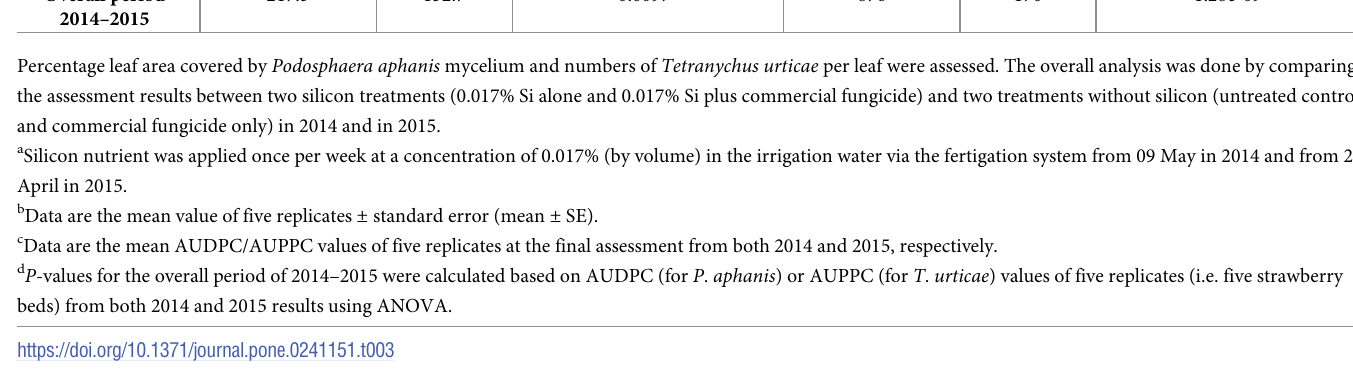
Treatments Silicon P -value between treatments without silicon treatments with and without